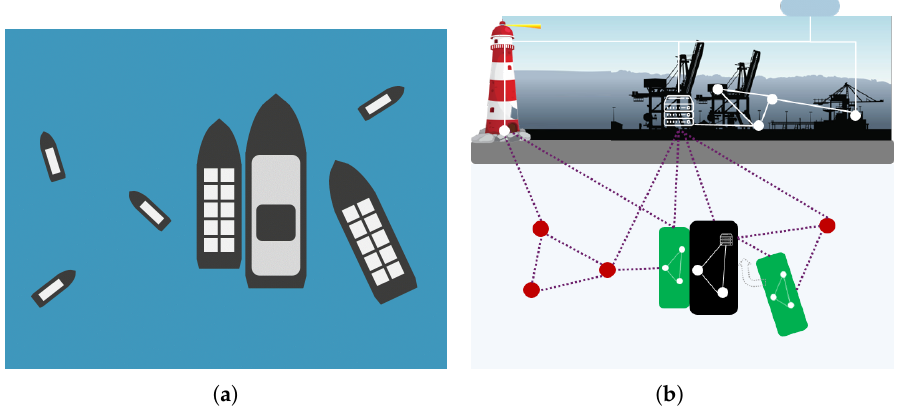
Figure 3. Bootstrapping the communication among neighboring vessels: ( a ) illustration of a docking scenario and ( b ) topology illustration of mesh network among neighboring